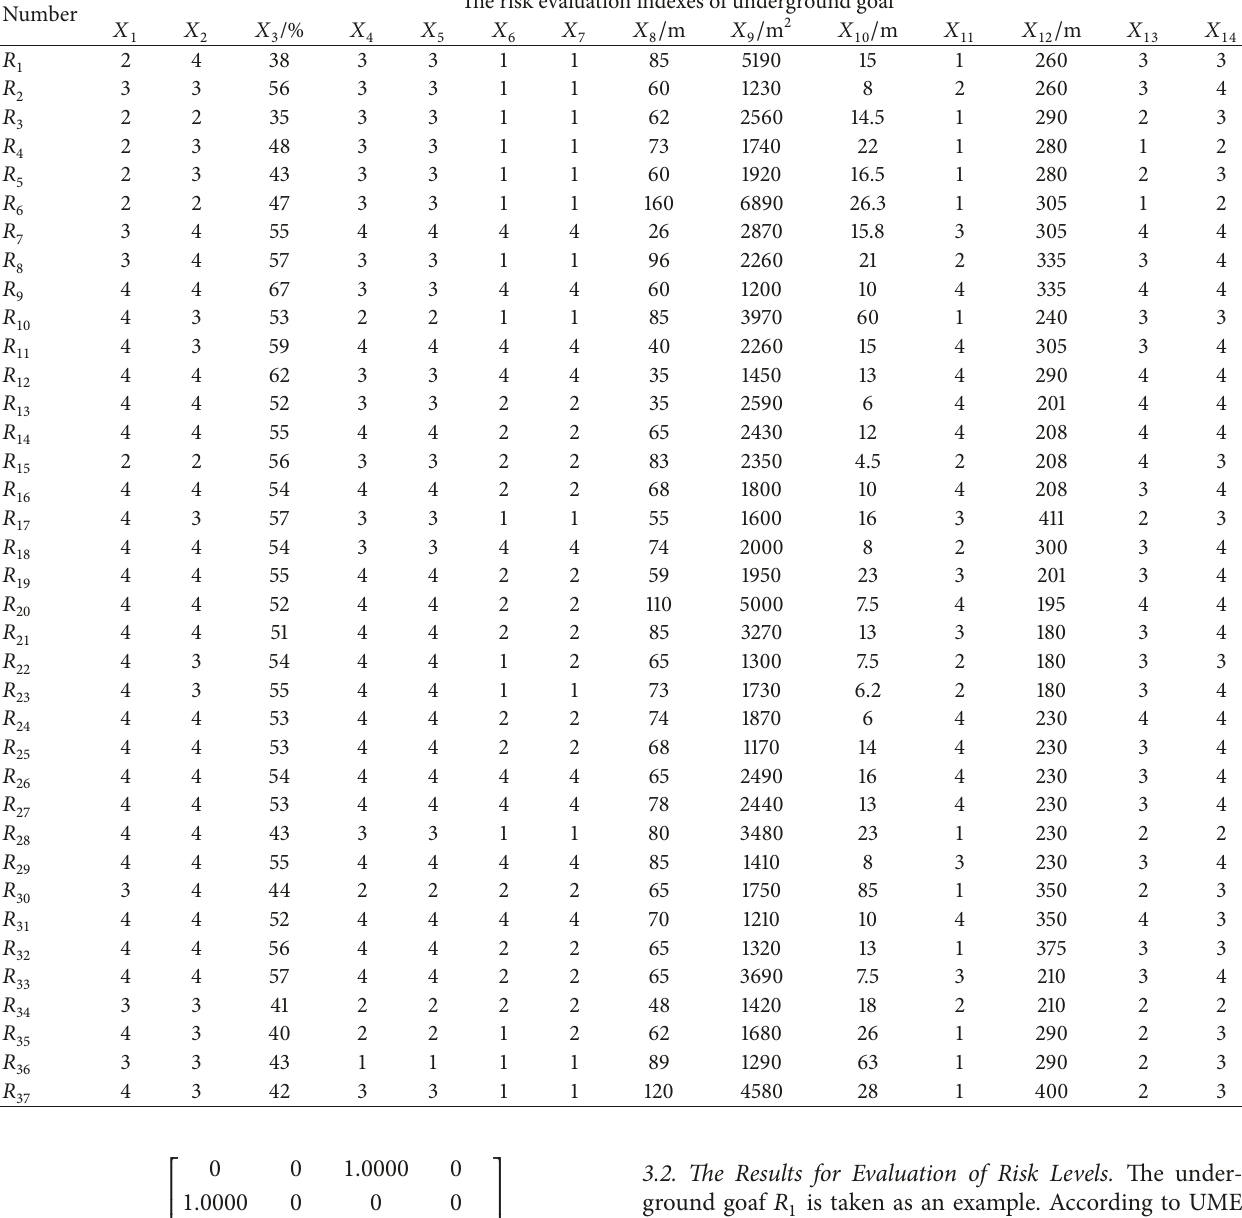
Table 6: Estimated and measured data for single evaluation indexes of 37 underground